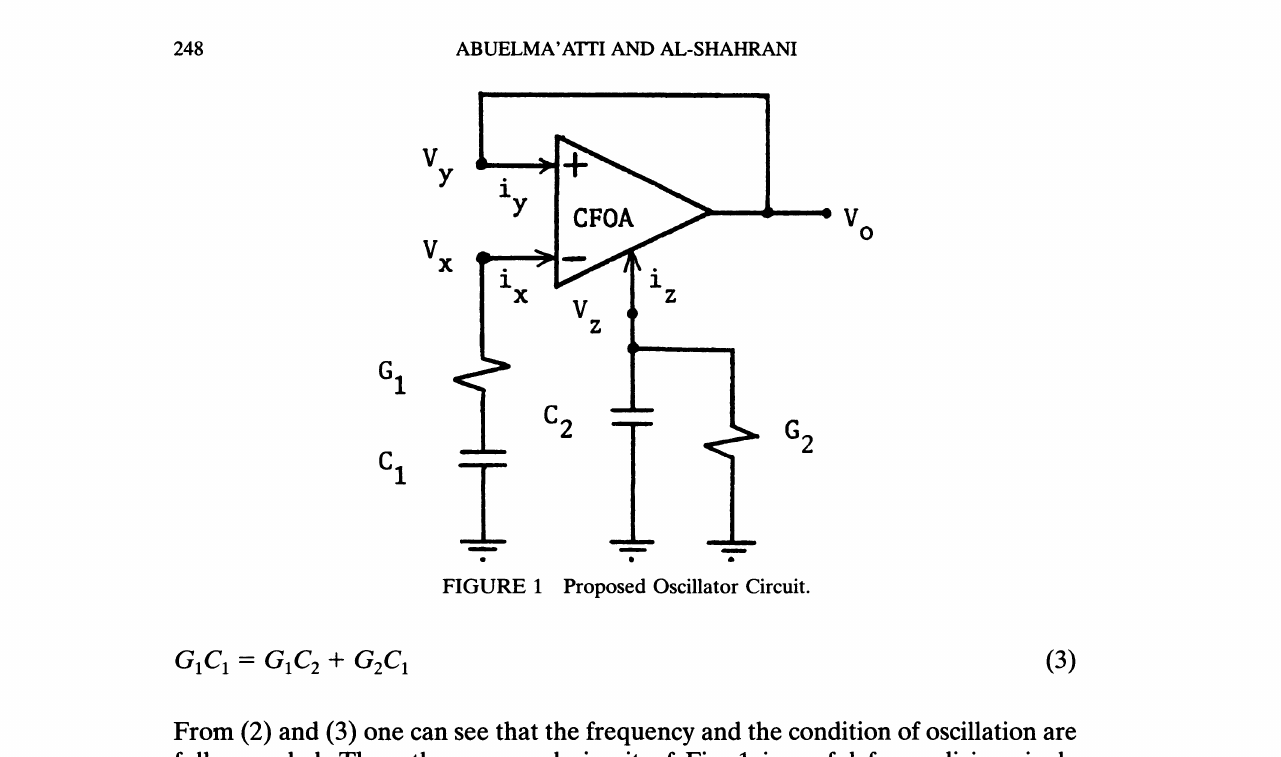
FIGURE 1 Proposed Oscillator